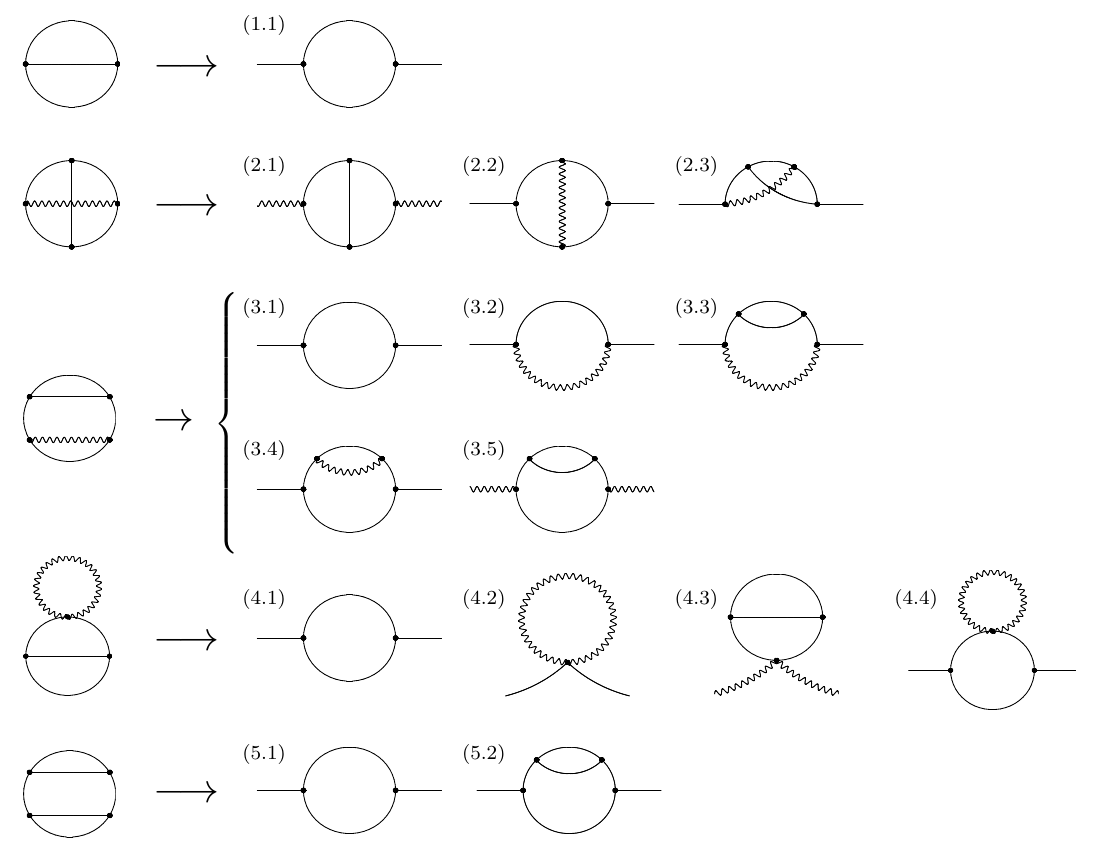
Figure 2 . Diagrams contributing to the two-point Green functions of the quantum gauge super(cid:12)eld V and of the matter super(cid:12)elds, obtained from graphs in (cid:12)gure 1 by cutting their internal lines. hand side. To obtain them, we need to calculate the two-point Green functions for the chiral matter super(cid:12)elds and for the quantum gauge super(cid:12)eld V in the two-loop